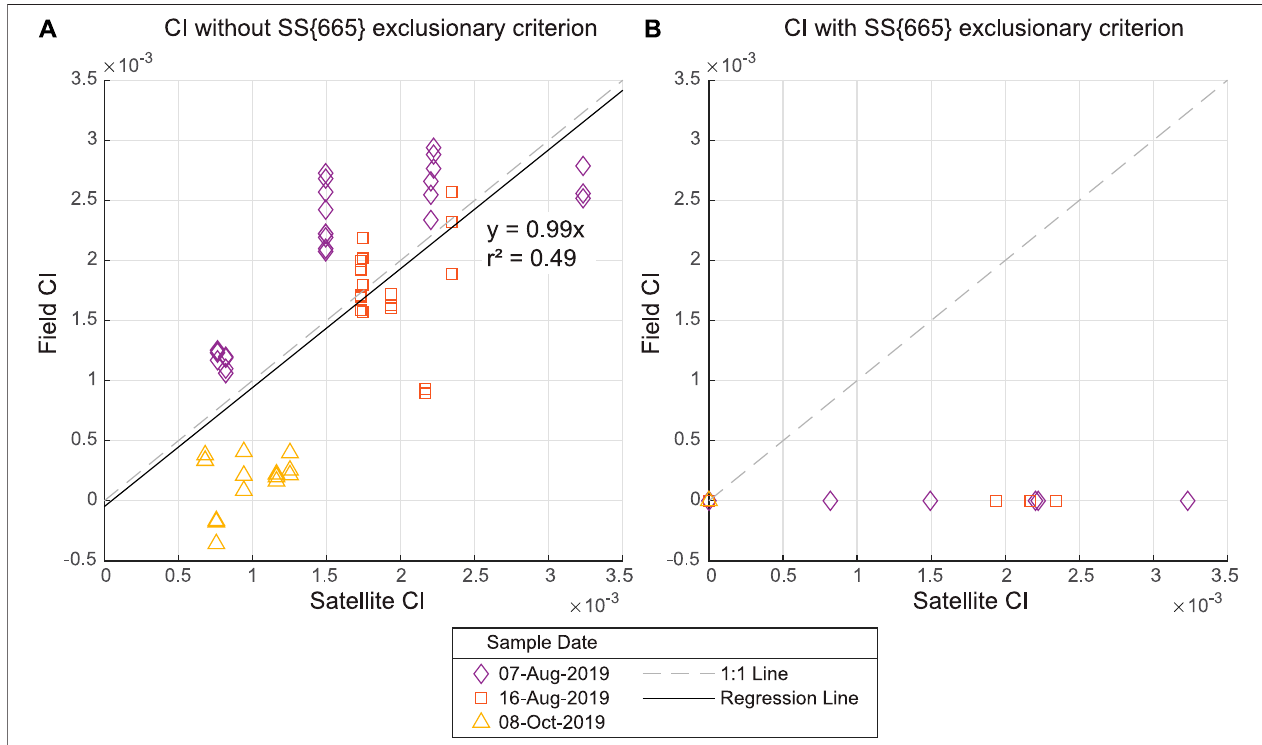
FIGURE 4 | (A) CI without the SS{665} exclusionary criterion for fi eld spectroradiometer measurements ( y -axis) and the Sentinel-3 measurements ( x -axis) for the same sampling dates (B) CI with the SS{665} exclusionary criterion for fi eld spectroradiometer measurements ( y -axis) and the Sentinel-3 measurements ( x -axis) for the same sampling dates. The CI calculated without the SS{665} exclusionary criteria demonstrates good correlation between the fi eld CI and satellite CI. The CI calculated with the exclusionary criteria for the fi eld measurements resulted in CI equal to zero in all cases. The CI calculated with the exclusionary criteria for the satellite measurements resulted in CI equal to zero for all of October 08, 2019